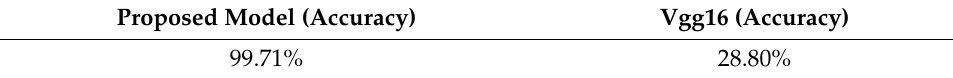
Table 5. Proposed model and CNN classification accuracy comparison.